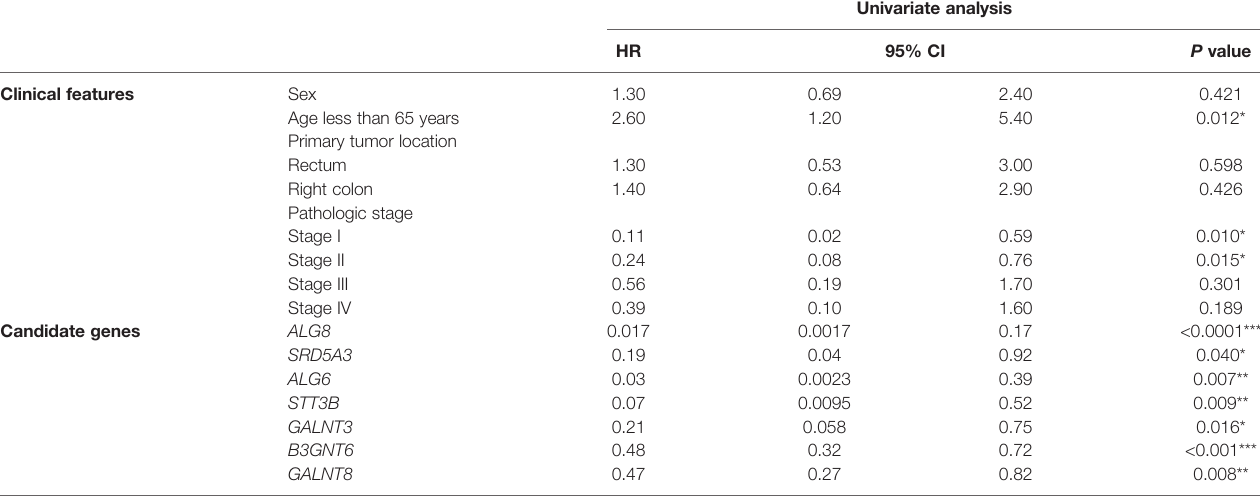
TABLE 3 | Univariate Cox regression analysis for clinical features and candidate